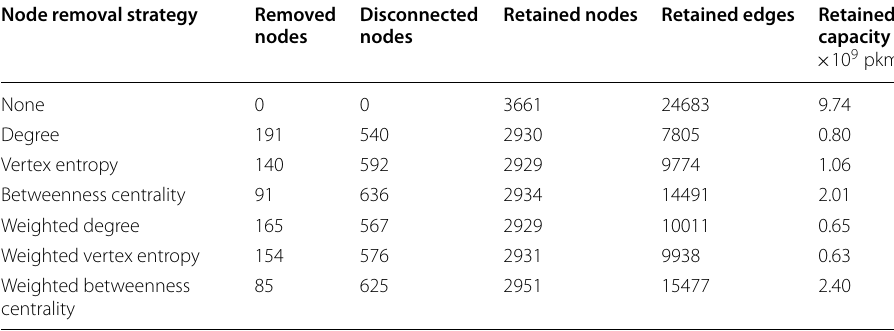
Table 1 Network metrics under different node removal strategies when the GC has been reduced to 80% of its original